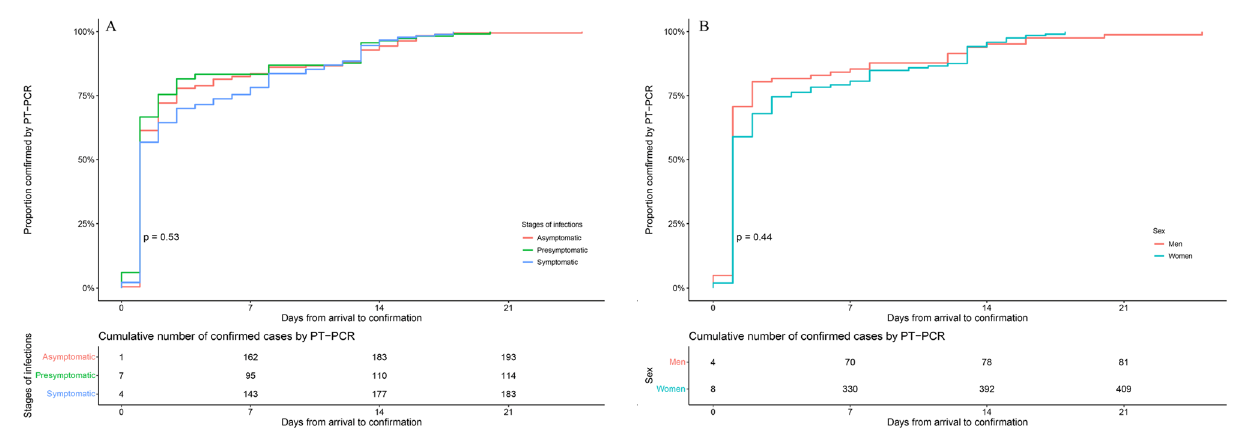
Figure 2. Time between arrival in Chengdu and SARS-CoV-2 confirmation by stages of infections ( A ), sex ( B ). Panel A shows estimates of the proportion of cases at different stages who are confirmed by PT-PCR, according to the number of days after arriving in Chengdu. We estimated that 95% of asymptomatic cases were confirmed by PT-PCR within 15 days (95% CI 13–16) after arrival, 95% of presymptomatic cases were confirmed by PT-PCR within 13 days (13–13) after arrival, 95% of symptomatic cases were confirmed by PT-PCR within 14 days (13–17) after arrival. Panel B shows estimates of the proportion of cases for different sexes who are confirmed by PT-PCR, according to the number of days after arriving in Chengdu. We estimated that 95% of male cases were confirmed by PT-PCR within 14 days (95% CI 13–15) after arrival, 95% of female cases were confirmed by PT-PCR within 14 days (12–16) after arrival. The upper confidence limit for female cases and presymptomatic cases are not available and estimated using the 95th quantile and corresponding lower confidence